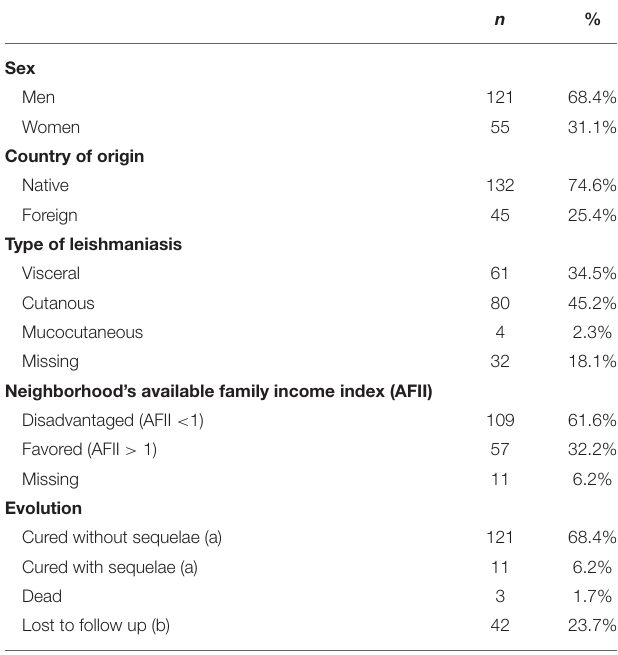
TABLE 1 | Descriptive statistics of the leishmaniasis cases reported in Barcelona between 1996 and 2019 ( n =